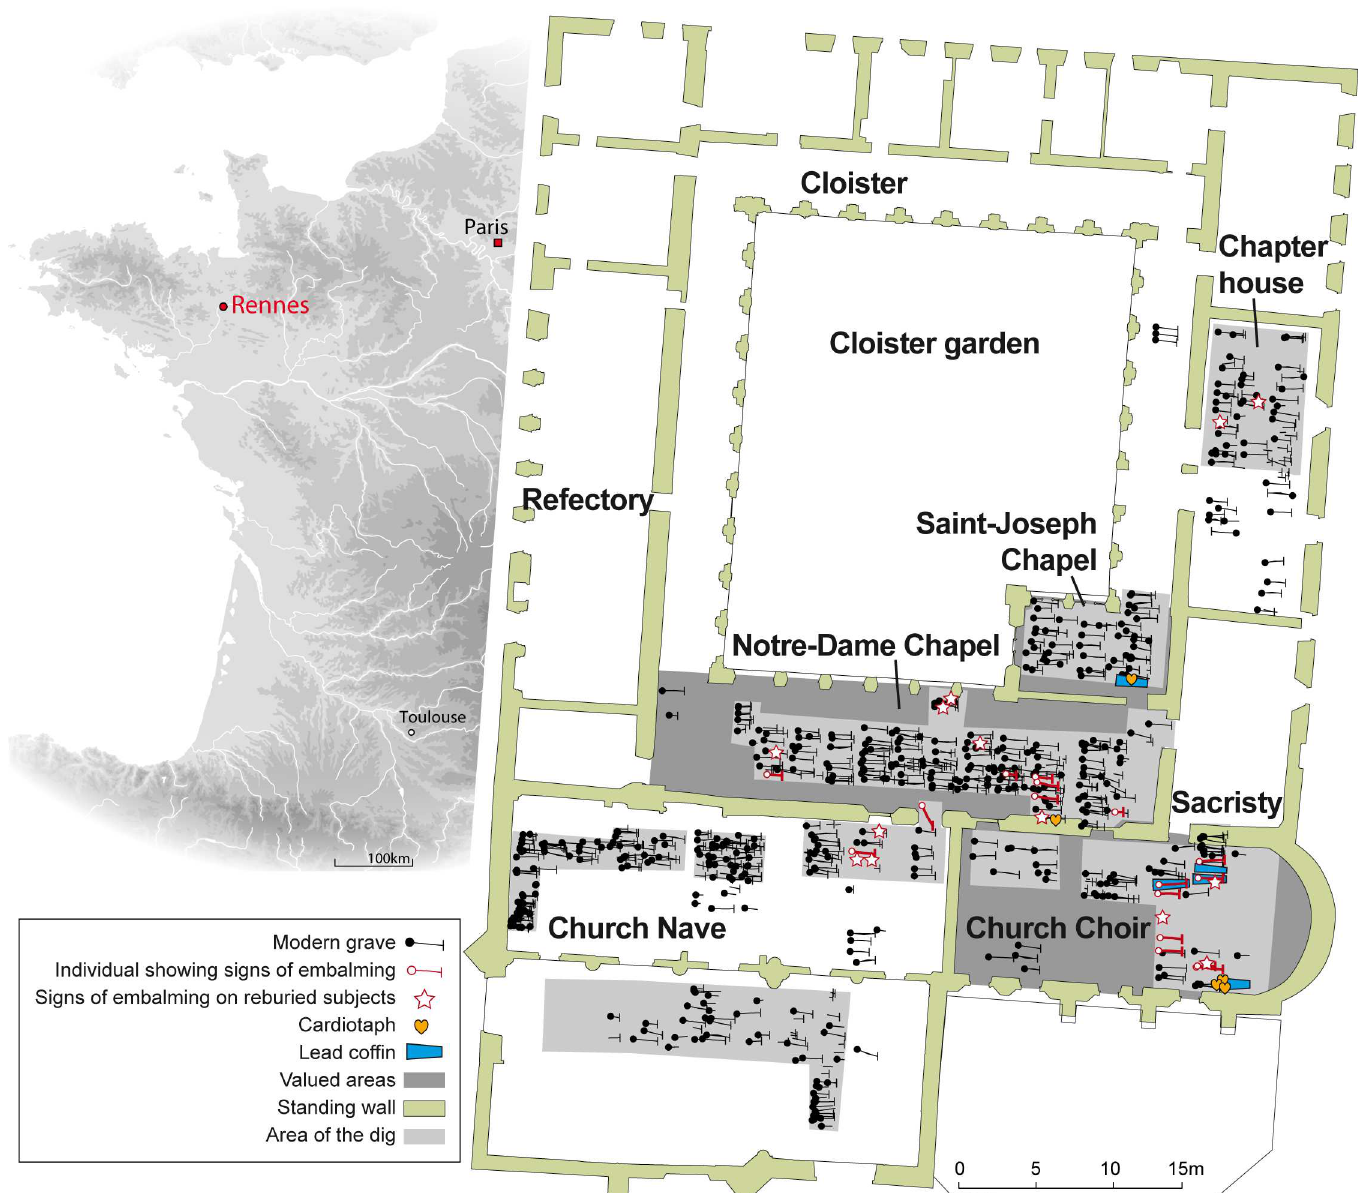
Fig 1. Location of the French city of Rennes and of the 16 th through 18 th century graves at the Jacobin convent in